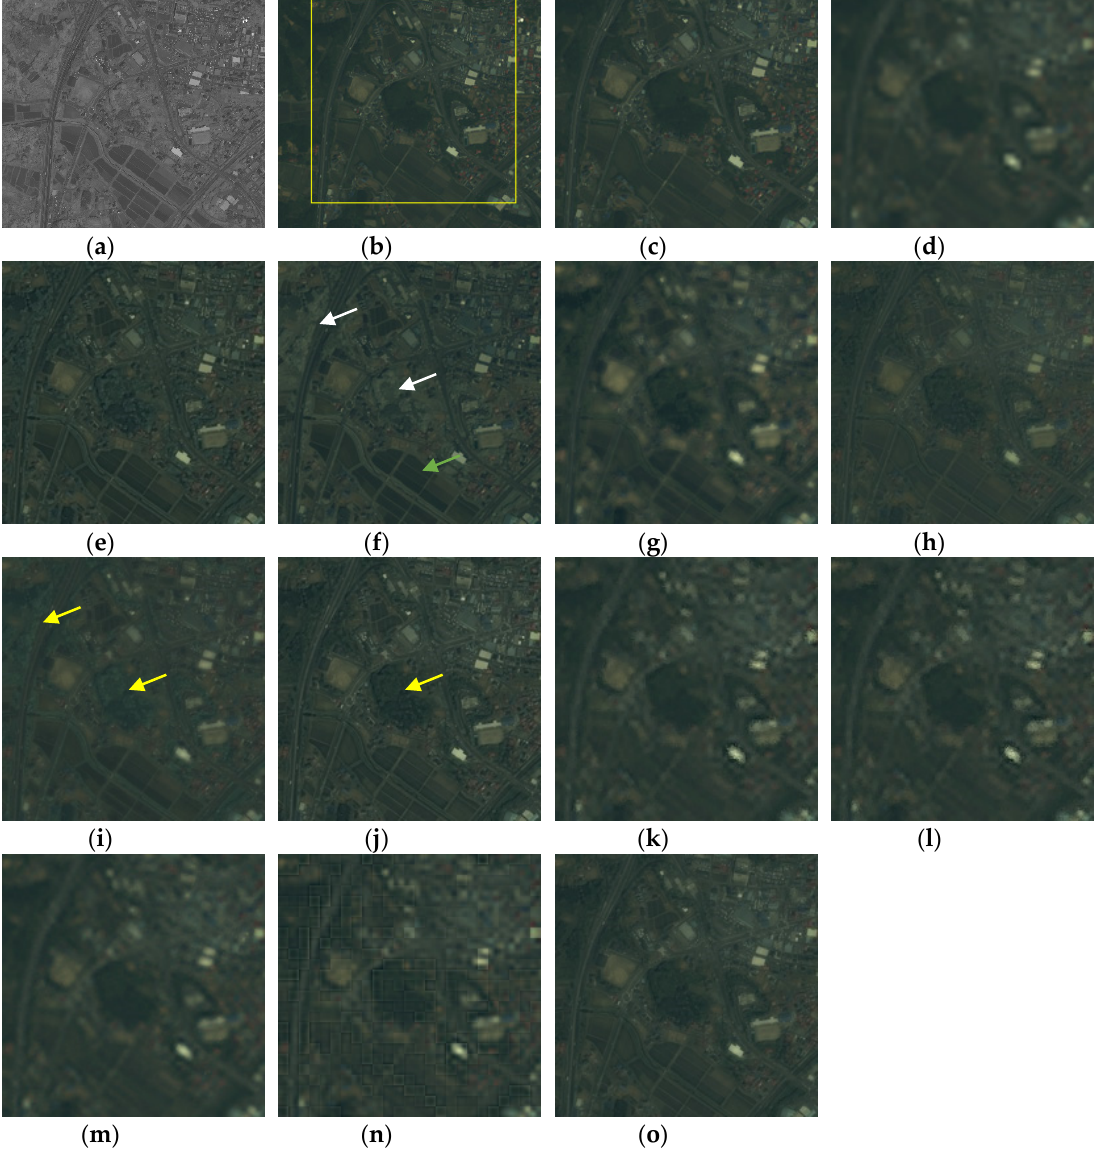
Figure 7. Reference and pansharpened Nihonmatsu images: ( a ) original PAN image (reference image), ( b ) original RGB image, ( c ) ground truth RGB image, ( d ) RGB image upsampled by bicubic interpolation, ( e ) fast IHS, ( f ) GS, ( g ) BDSD, ( h ) WLS, ( i ) MDSIm, ( j ) SCMP, ( k ) ISSR (natural images were used for training), ( l ) ISSR (Nihonmatsu images were used for training), ( m ) SR-D, ( n ) SRayas method, ( o ) proposed method ( τ = 0.3 ) .